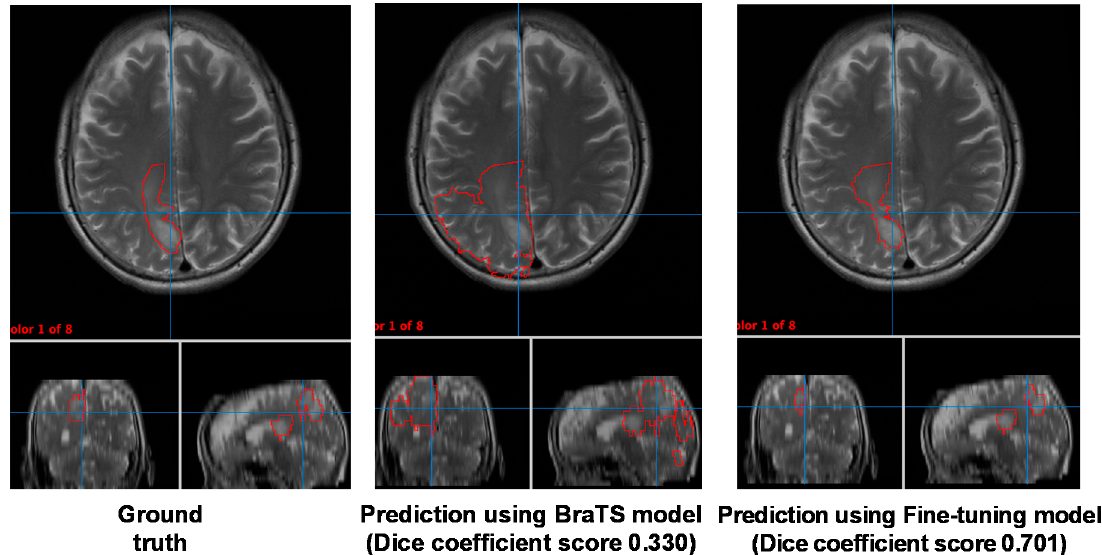
Figure 4. Segmentation results on Case 3. The left column is ground truth (made by a skilled radiologist), the middle is predicted by the BraTS model, and the right is predicted by fine-tuning model specialized for the facility has Case 3. The volume of interest (VOI) predicted by the BraTS model had an area that didn’t seem to be a brain tumor. However, that by fine-tuning model specialized for the facility has Case 3 only have an area that seemed to be a tumor.